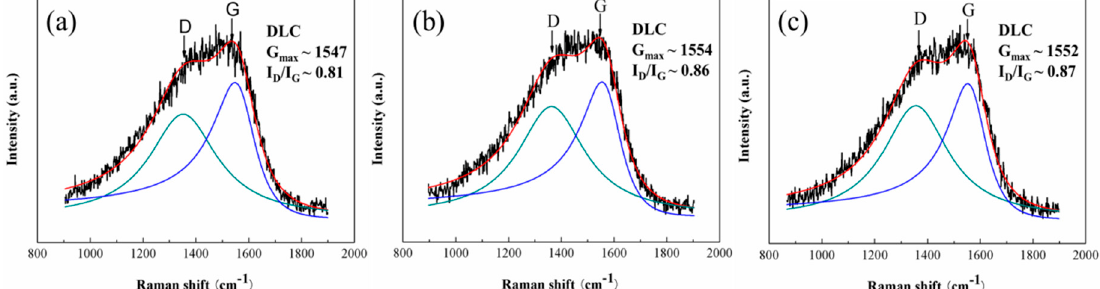
Figure 10. The Raman spectra of: ( a ) as-deposited a-C; and the wear tracks on a-C under the lubrication of: ( b ) pure PAO; and ( c ) ZrO 2 -NPs dispersion. The insets show the fitting results of G peak position (G max ) and the I D /I G ratio (height ratio).